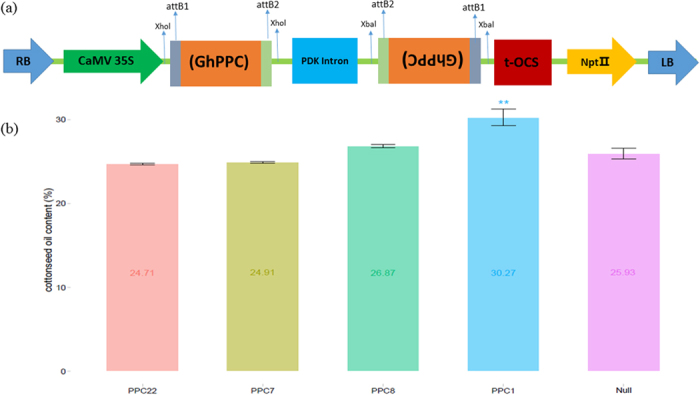
Schematic representation of T-DNA regions of the RNAi vectors and cottonseed oil content in T1 transgenic lines.(a) 35s-GhPPC RNAi vectors. (b) Cottonseed oil content in transgenic GhPPC lines and null plants; All the experiments were repeated three times. Bar graphs represent the average oil content ± SD of three replicates. *Denotes significant differences (P < 0.05).